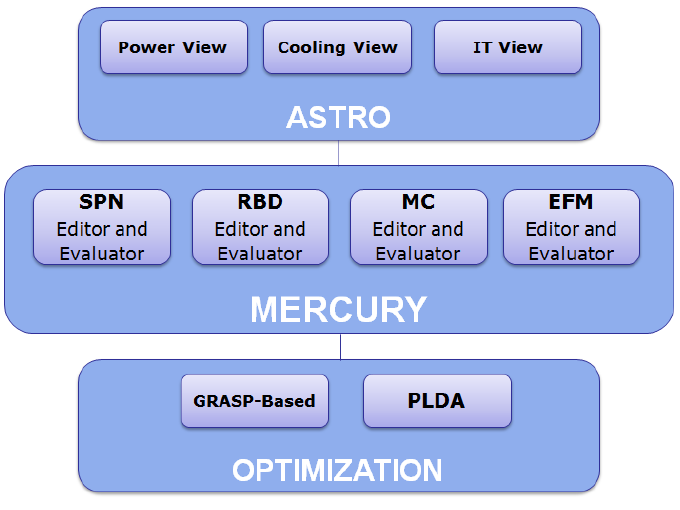
Figure 8. Evaluation environment. SPN, stochastic Petri net; MC, Markov chain; EFM, energy flow model; GRASP, Greedy Randomized Adaptive Search Procedure; PLDA, power load distribution